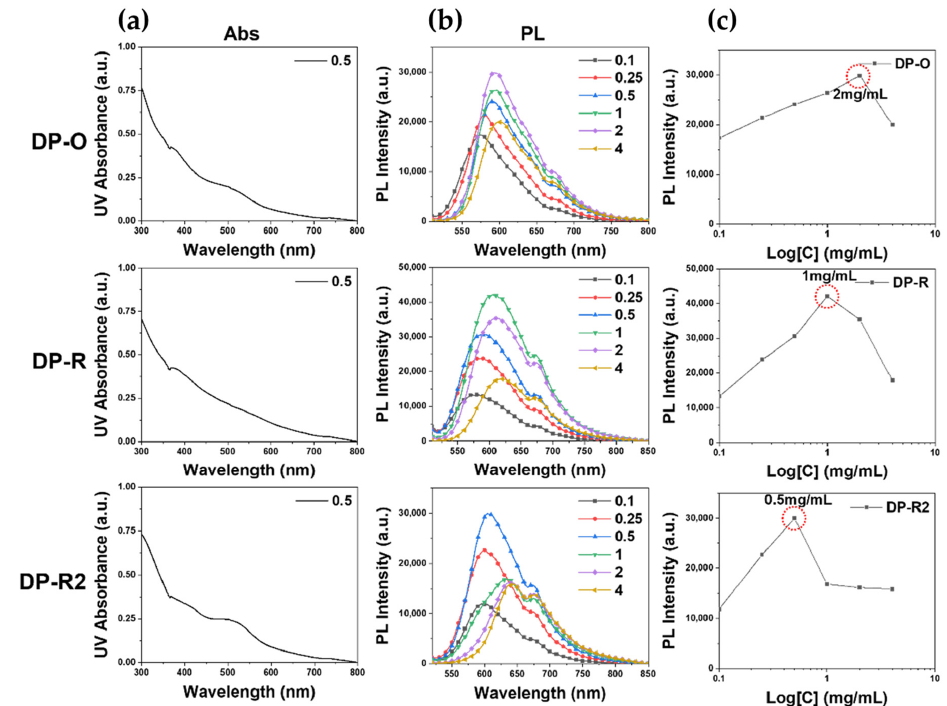
Figure 4. ( a ) UV/Vis spectra of DPP-based AIE NPs prepared at a concentration of 0.5 mg/mL, ( b ) PL spectra, and ( c ) intensity of maximum emission wavelength of AIE NPs by dye concentration. (Excitation wavelength = 365 nm).